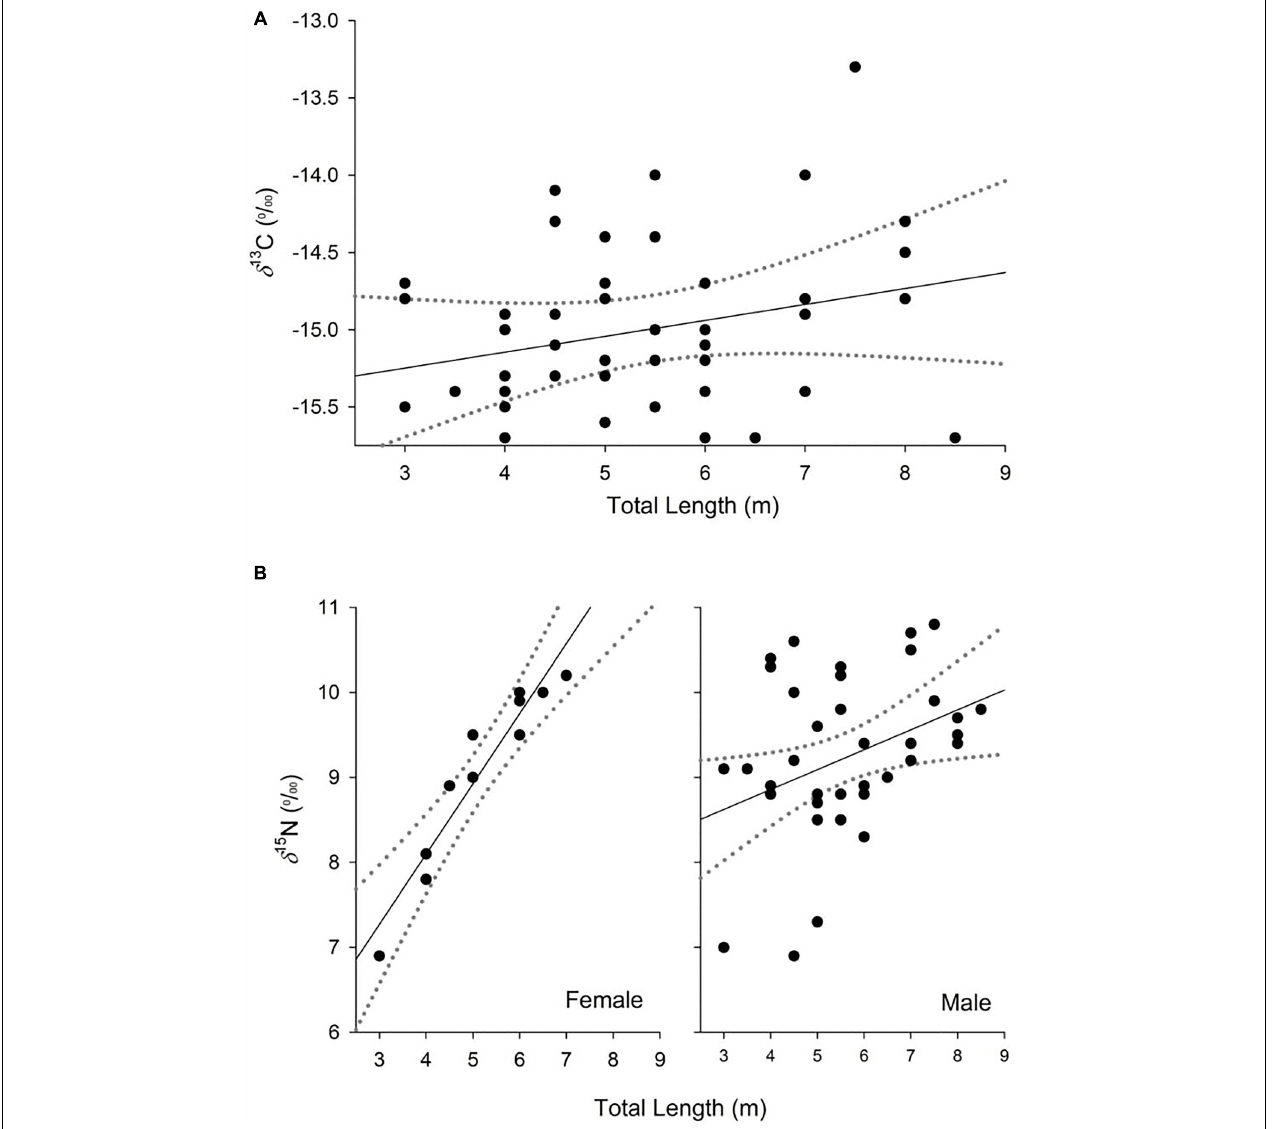
FIGURE 2 | Partial dependence plots of the relationship between δ 13 C (A) and δ 15 N (B) values and the explanatory variables for the top-ranked models from analysis of whale shark dermis. Dashed lines represent 95% confidence